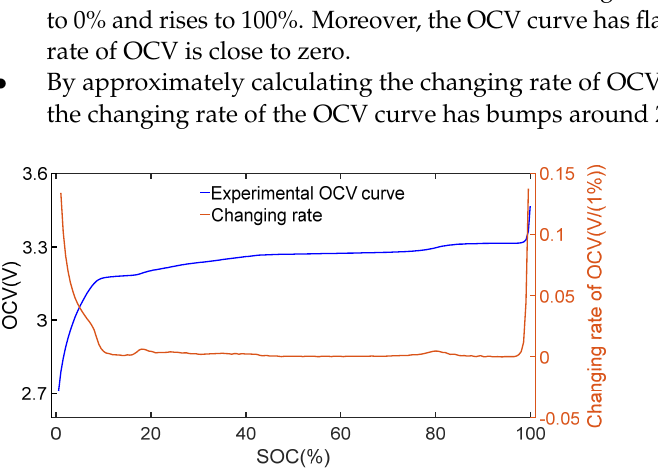
Figure 5. An OCV curve of LiFePO 4 (LFP) battery with changing rate of OCV over SOC. Different OCV models in Figure 6 are adopted to fit OCV curve, and the results shows that accuracy fluctuates when SOC is around 10%, 20% and 80%. By setting interval (15%, 25%) and interval (75%, 85%) as the conversion region, OCV curve is divided into three parts. The corresponding sub-intervals are (0, 25%), (15%, 85%) and (75%, 100%). The OCV model in Figure 6c is adaptable to the strongly non-linearity of the LFP battery, which makes it become the OCV sub-model of sub-intervals (0%, 25%) and (75%, 100%). The OCV model in Figure 6b retains great precision in sub-interval (15%, 85%). The OCV sub-models adopted for the LFP battery are presented in Table 2.